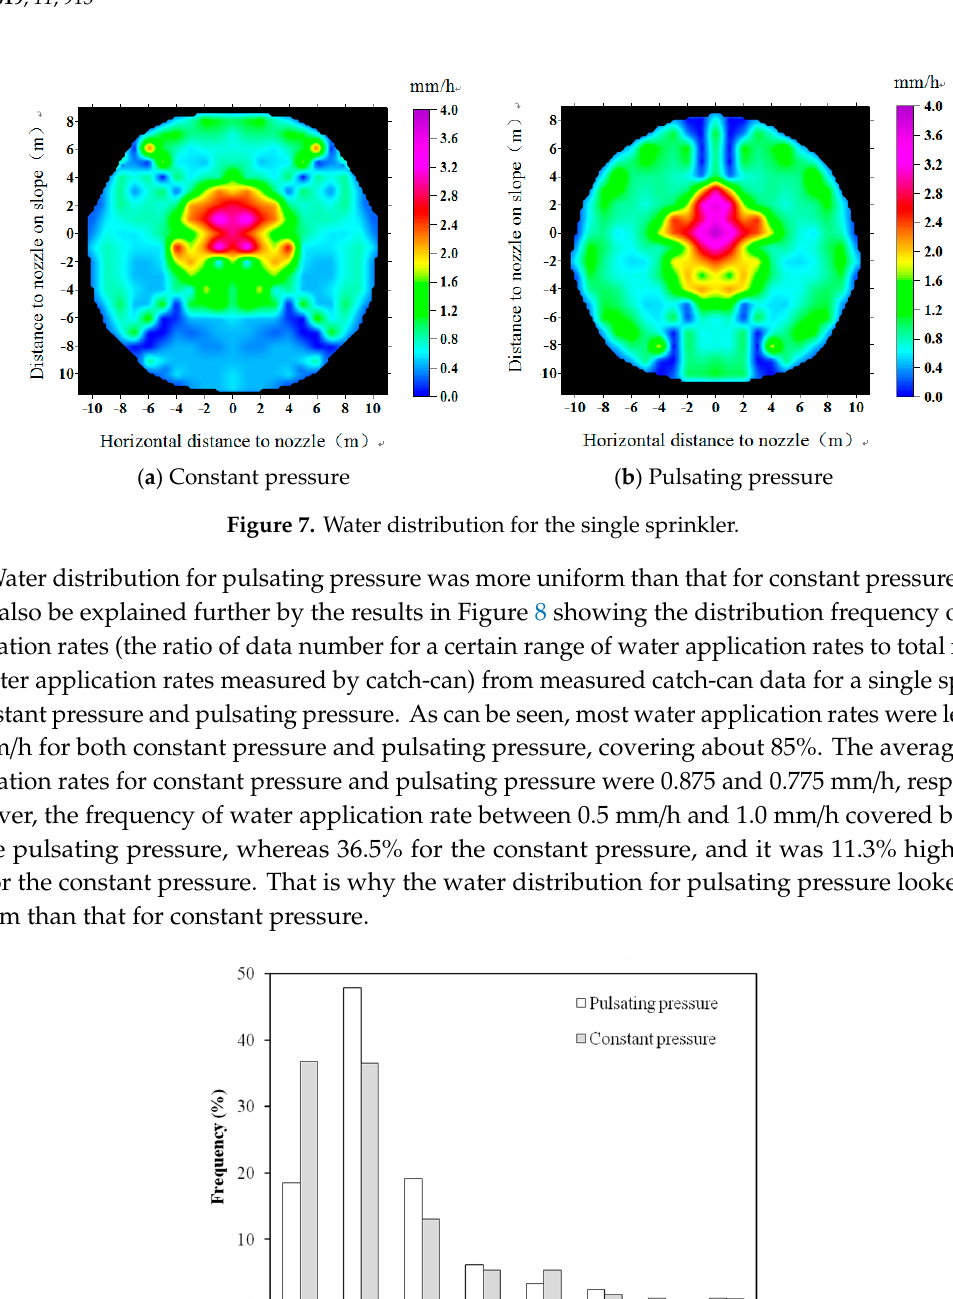
ff erent pressure